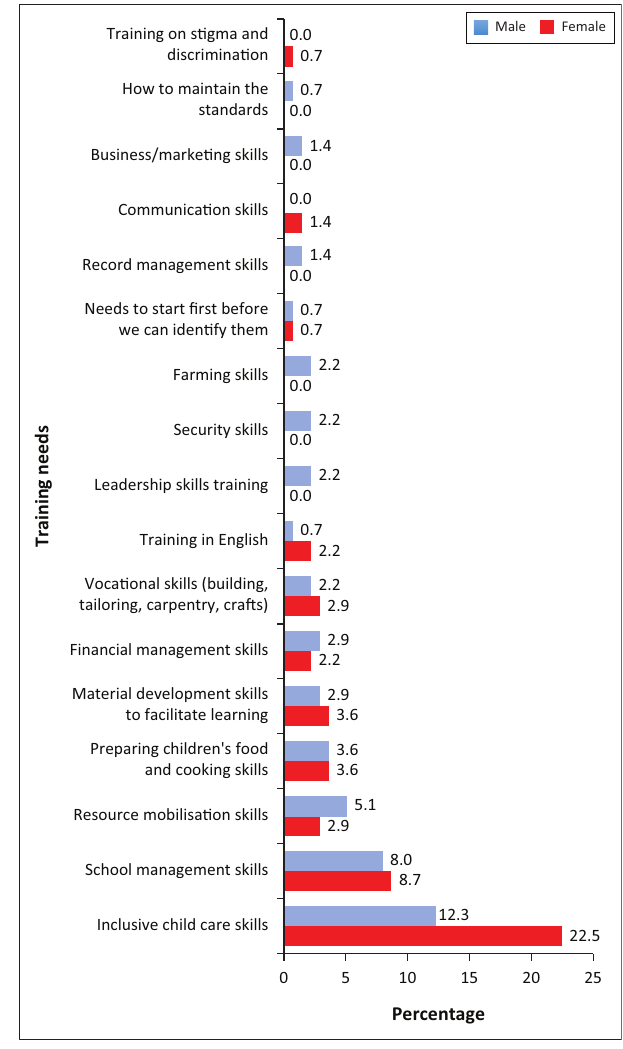
FIGURE 4: Skills training needed by gender.